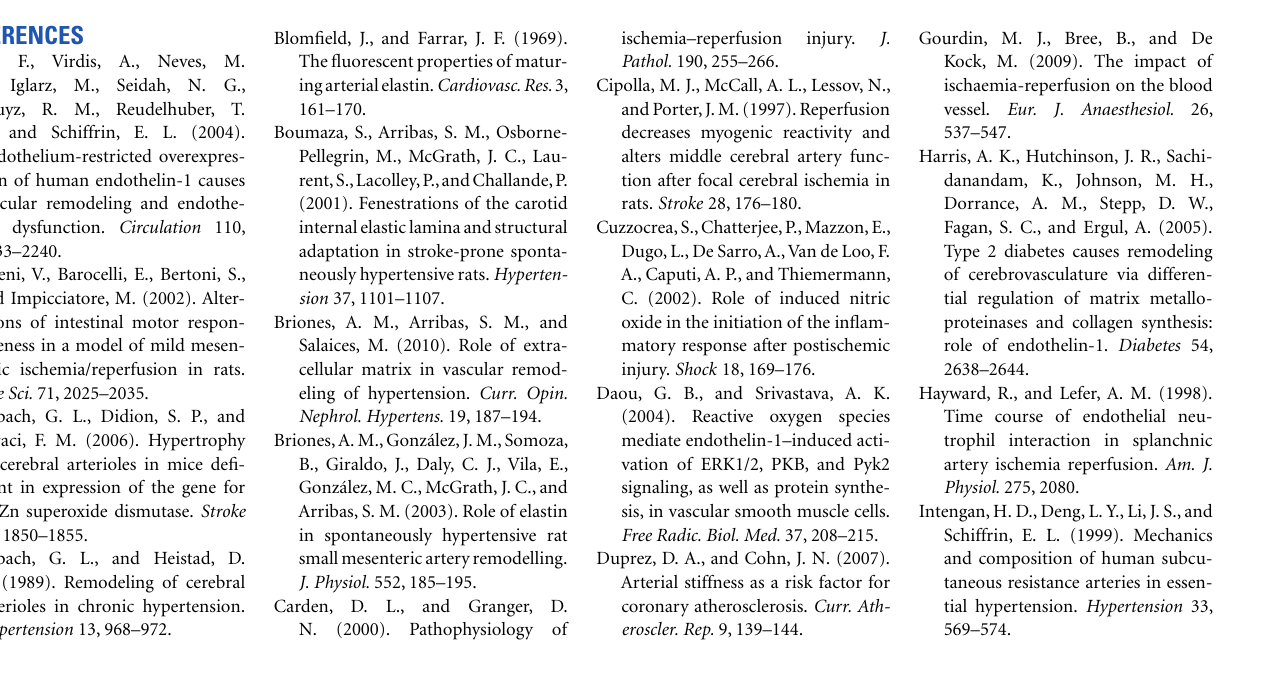
endothelial layer; MED, media layer; IEL, internal elastic lamina. Image size, 238 μ m × 238 μ m. Data are the mean ± SEM of n = 6–8. ** P < 0.01; *** P < 0.001 SO vs. IO and ++ P < 0.01; +++ P < 0.001 IO vs. IO + TZS by one-way ANOVA followed byTuckey